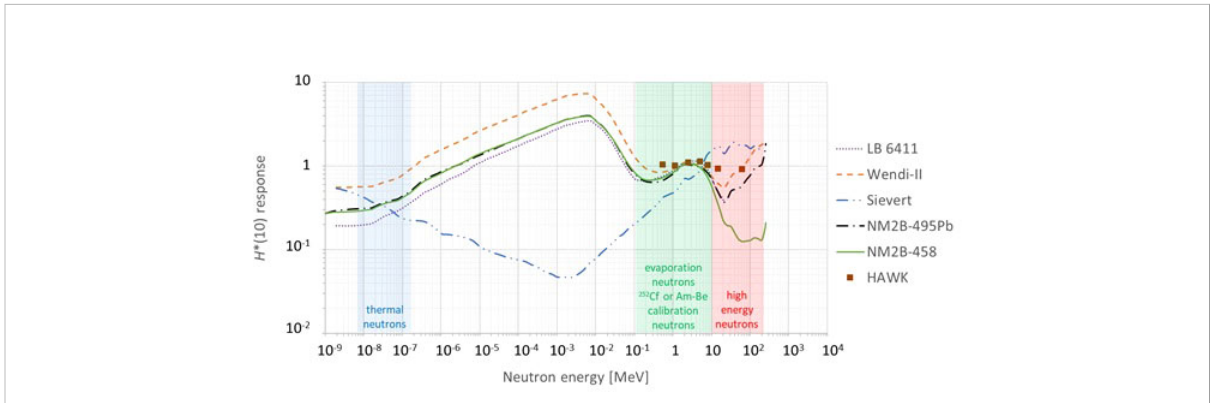
FIGURE 2 Plot with the simulated (lines) or measured (data points) H*(10) energy response functions of the different ambient neutron monitors used during the measurement campaigns at Skandion and CCB [LB 6411 (7), Wendi-II (8), Sievert [this work], NM2B-495Pb and NM2B-458 (9), HAWK